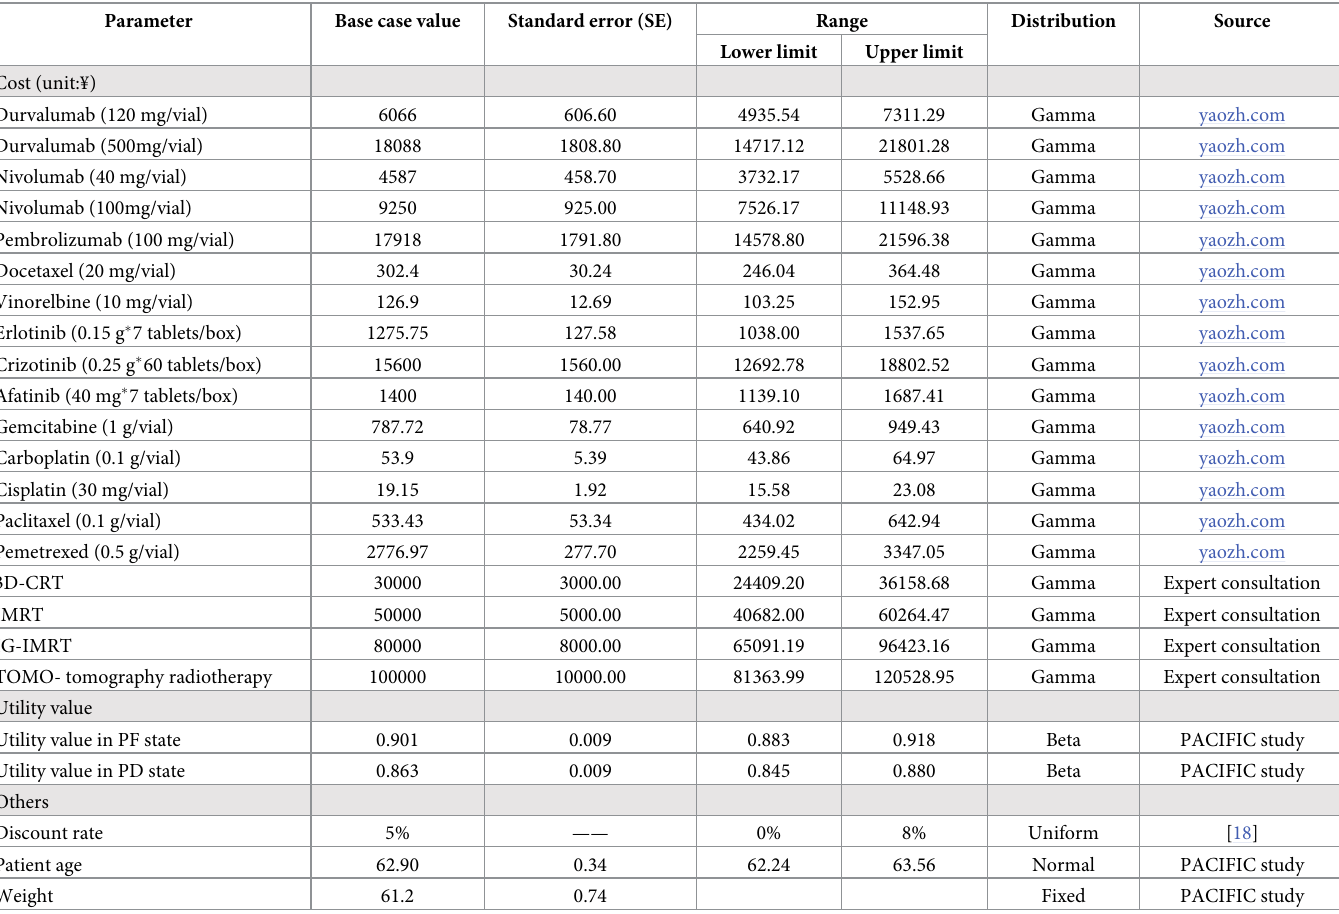
Table 2. Model parameters and distributions.